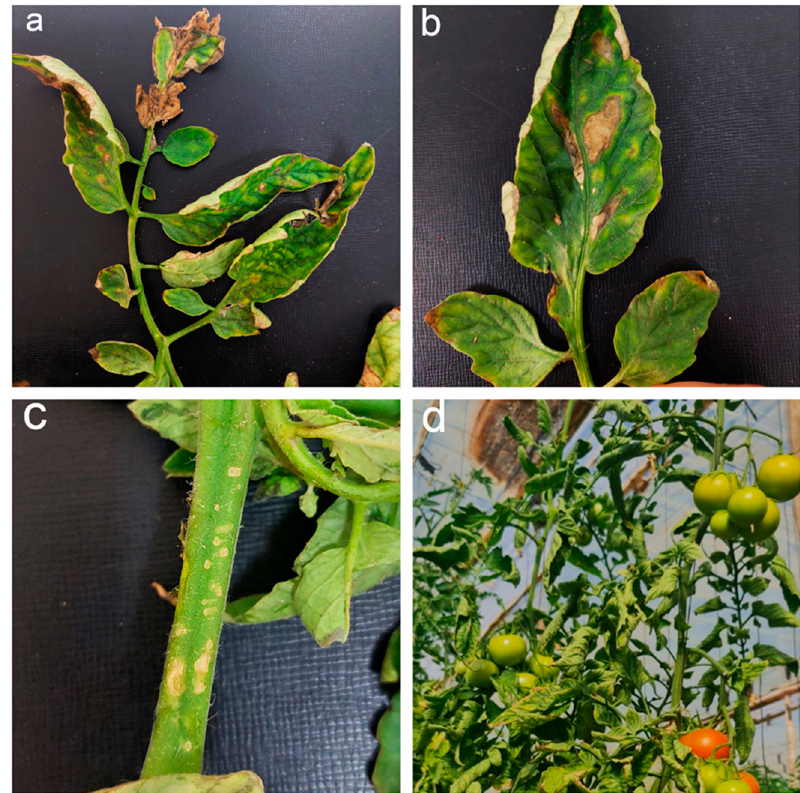
Figure 3. Typical bacterial canker symptoms on tomato plants; ( a ) marginal necrosis of leaflets and petioles, ( b ) areas of the desiccated leaf, ( c ) small white blister like lesions in the stem, and ( d ) unilateral wilting of leaves of tomato plants.